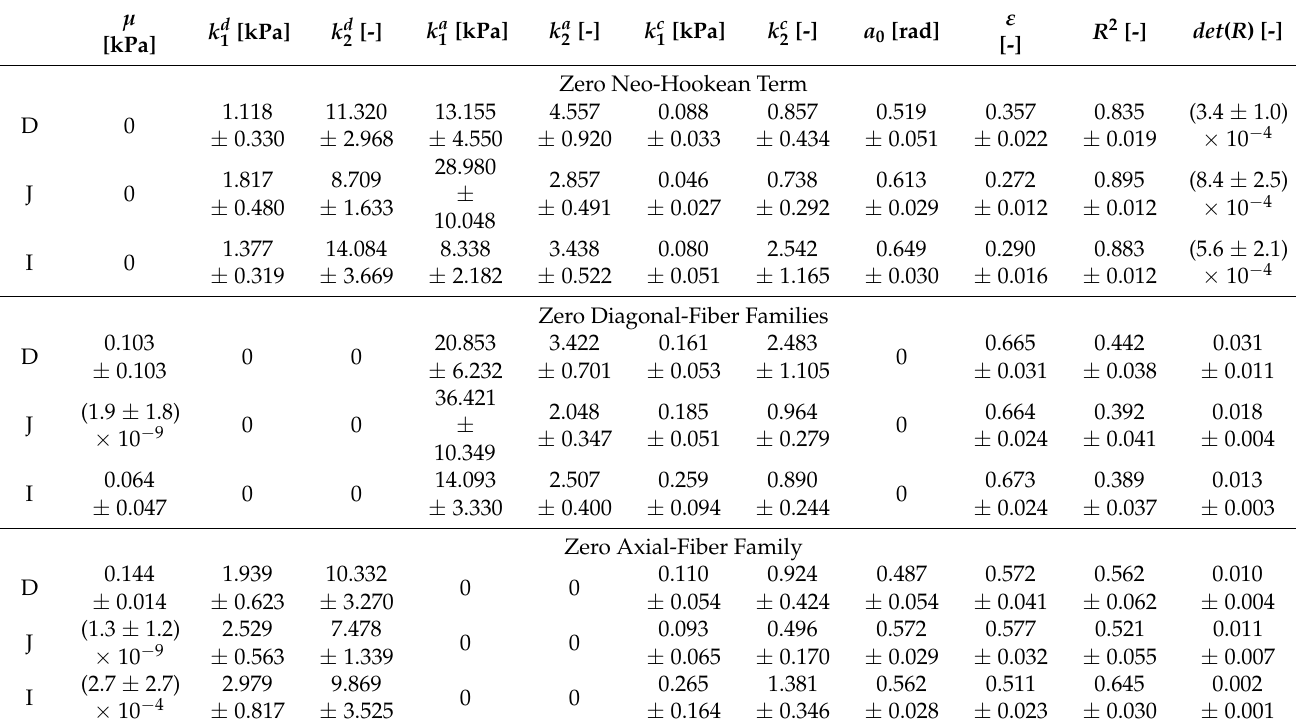
Table 2. Validation of the parameters of the neo-Hookean and four-fiber family terms for pooled data from the duodenum, jejunum, and